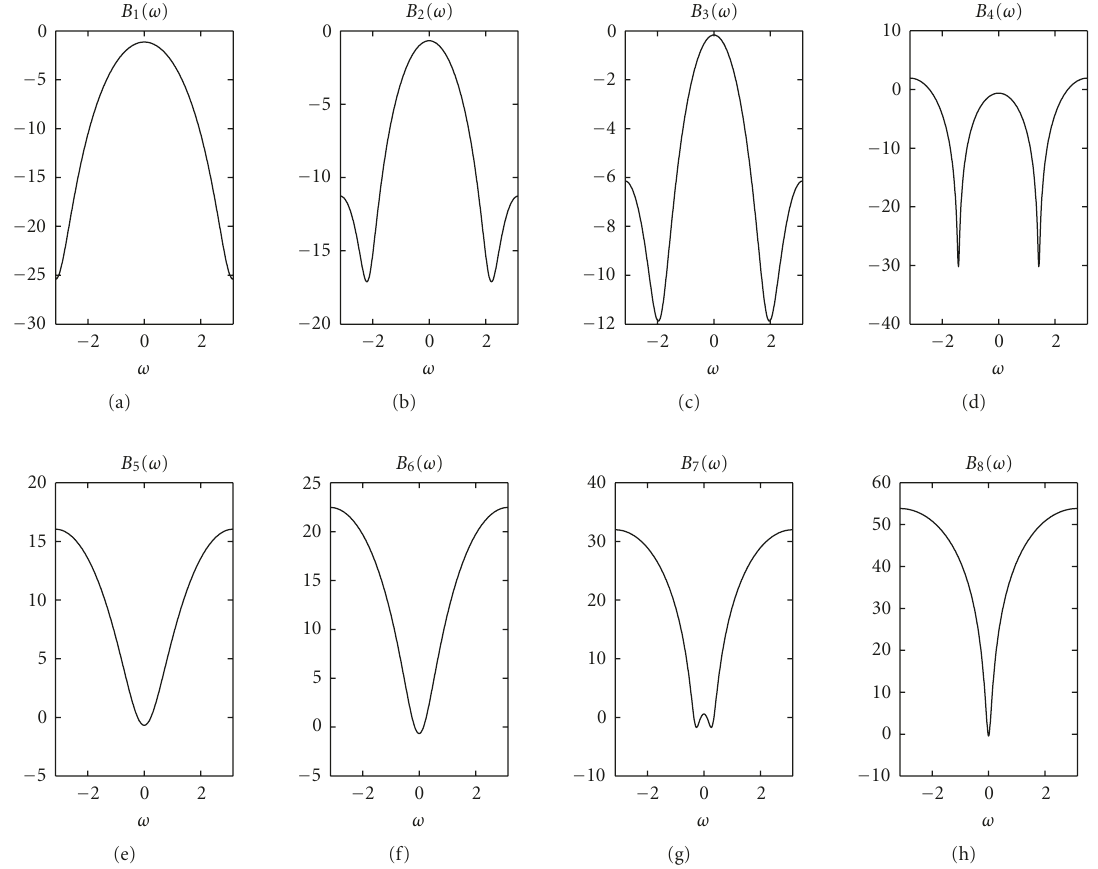
Figure 5: Equivalent filter frequency responses for BOSR algorithm coe ffi cients. Frequency responses of B 1 – B 8 are shown in dB